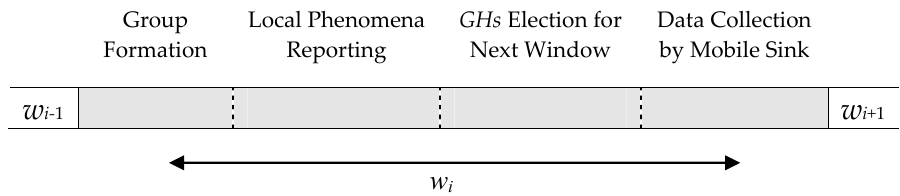
Figure 1. Phases of phenomena detection in the proposed scheme.